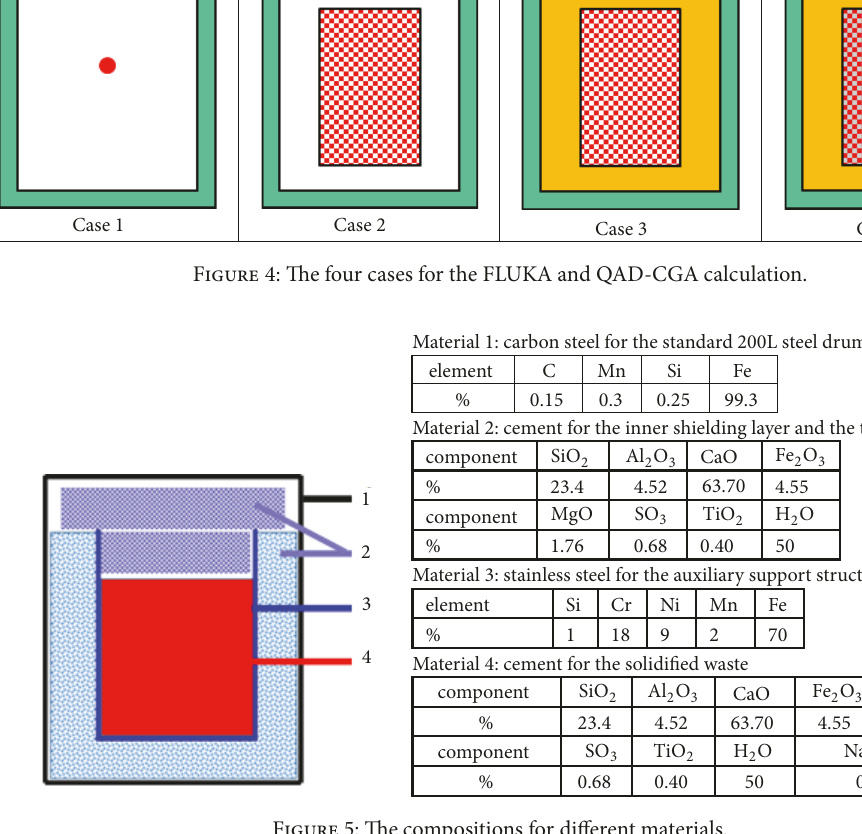
Figure 5: The compositions for different